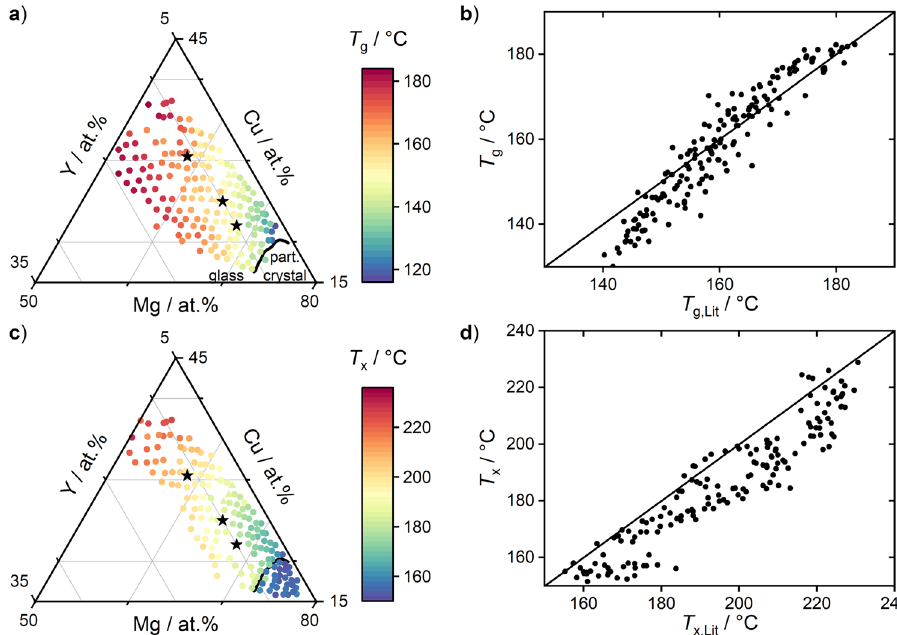
Fig. 3 T g and T x in Mg – Cu – Y. a , c Composition maps determined through FIM: Values vary smoothly and correlate with the pure element melting temperatures (see SFig. 3). b , d Validation by comparison with literature values T g,Lit and T x,Lit : Our FIM values correlate strongly with DSC-based literature values, con fi rming that FIM yields qualitatively and quantitatively reliable data. T x values are systematically lower by ~10 °C, indicating a reduced crystallization resistance in the fi lm. Note: In Figs. 3 and 4, black stars represent bulk-glass forming compositions. Triangle markers (near middle star) represent curves in Fig. 2.c.4. Sets of available composition map points can differ. For example, some points available at high Y concentrations in ( a ) are not available in ( c ). Here, the expanding fi lms burst before reaching T x